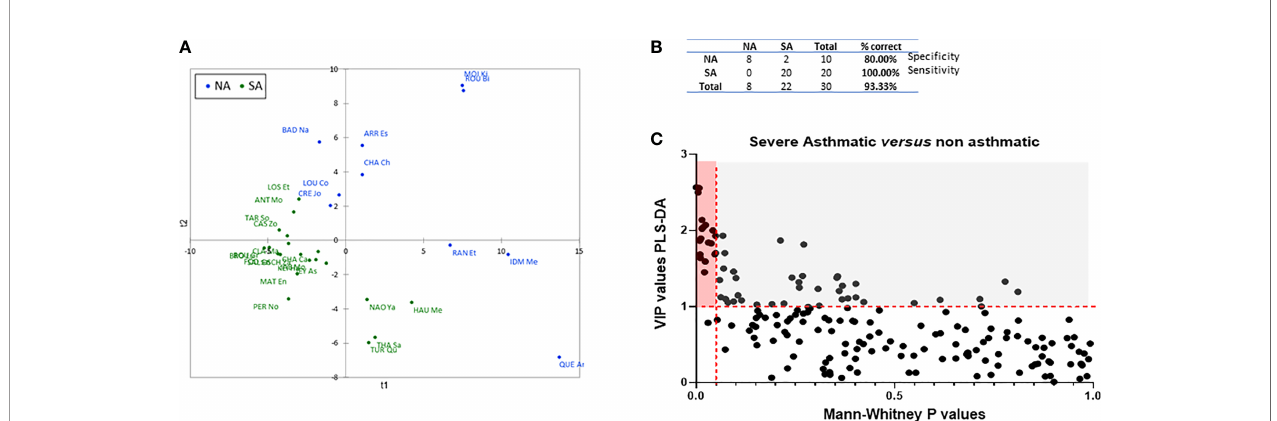
FIGURE 2 | Modelling of all immune constituents measured to discriminate between children with SA and control (NA). (A) Graph of all individuals obtained by PLS-DA modelling. SA patients are indicated in green, and NA patients in blue. (B) Speci fi city and sensitivity of the patient classi fi cation provided by the PLS-DA modelling. (C) VIP x p values plot of all analyzed immune constituents and selection of the most discriminating and signi fi cant ones to distinguish between SA and NA patients (red rectangle: VIP > 1, p values < 0.05). The variables that largely participated in the PLS-DA model are shown in the grey region of the graph, i.e., those that belong to the set of variables that allow discrimination between asthmatic and non-asthmatics but show p > 0.05 in the MW